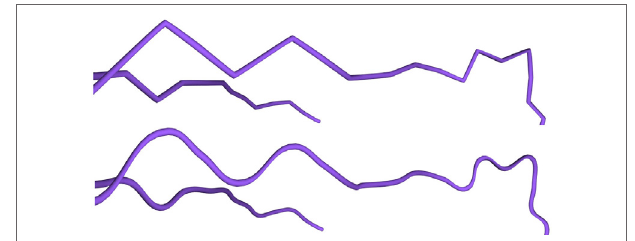
FIGURe 12 | Trajectory smoothing. Top image: refinement method applied to dendrites without any trajectory smoothing. Bottom image: refinement applied to the same dendrites using the Hermite spline-based method proposed in this paper.